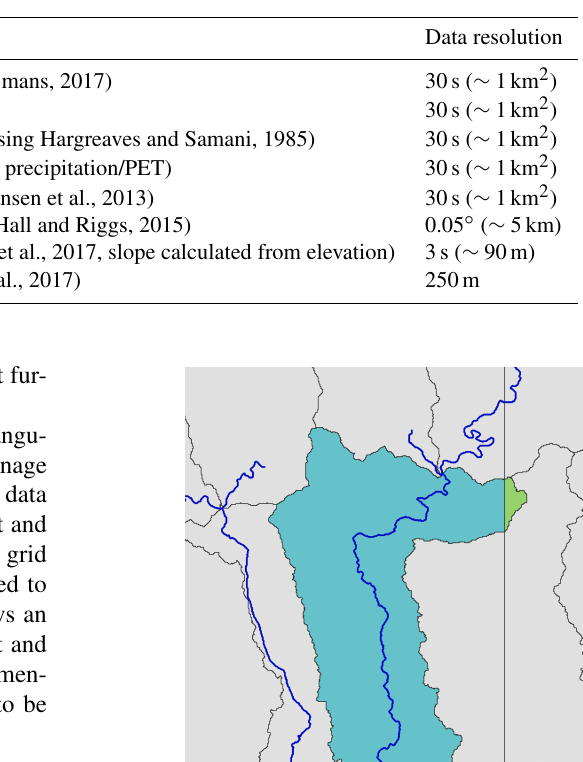
Table 2. List of catchment characteristics used for parameter regionalization and corresponding data sources.